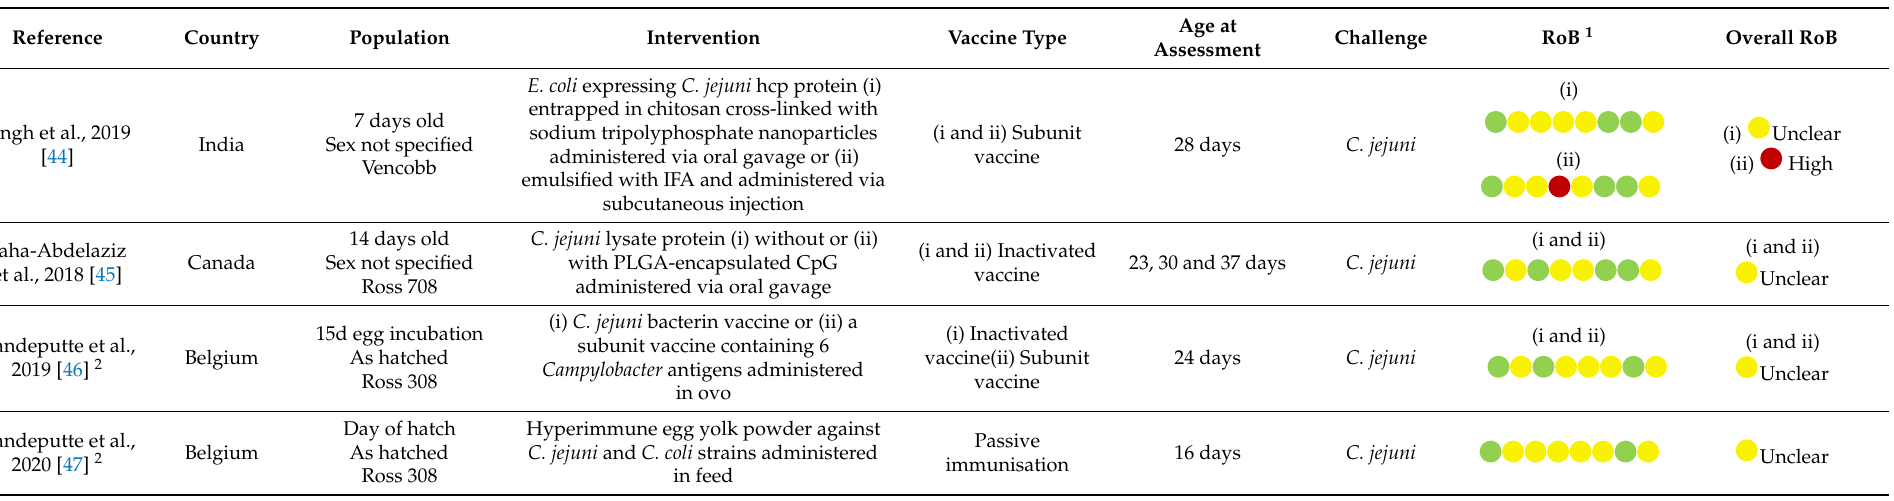
Table 2. Summary of key characteristics of studies that investigated the effects of Campylobacter vaccines on caeca Campylobacter.